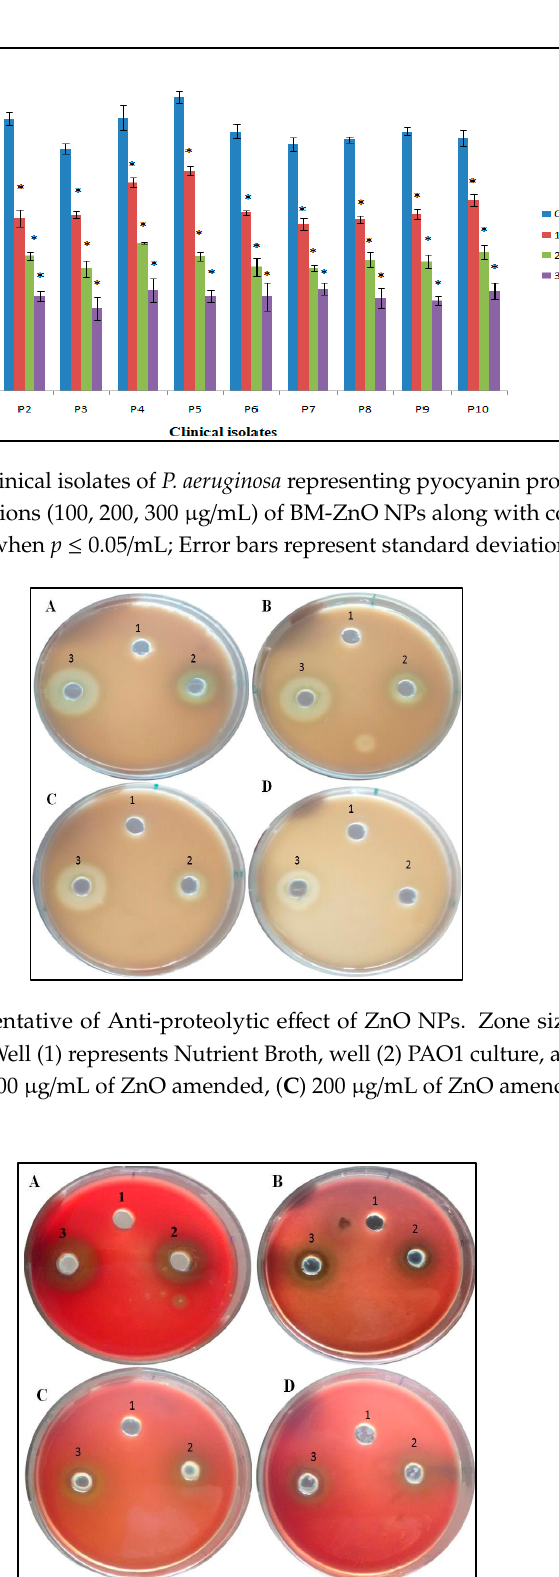
Figure 9. Images representative of Anti-hemolysis effect of ZnO NPs. Zone size decreases as the concentration increases. Well (1) represents Nutrient Broth, well (2) PAO1 culture and well (3) Clinical isolate. ( A ) Control, ( B ) 100 µg/mL of ZnO amended, ( C ) 200 µg/mL of ZnO amended, ( D ) 300 µg/mL of ZnO amended.